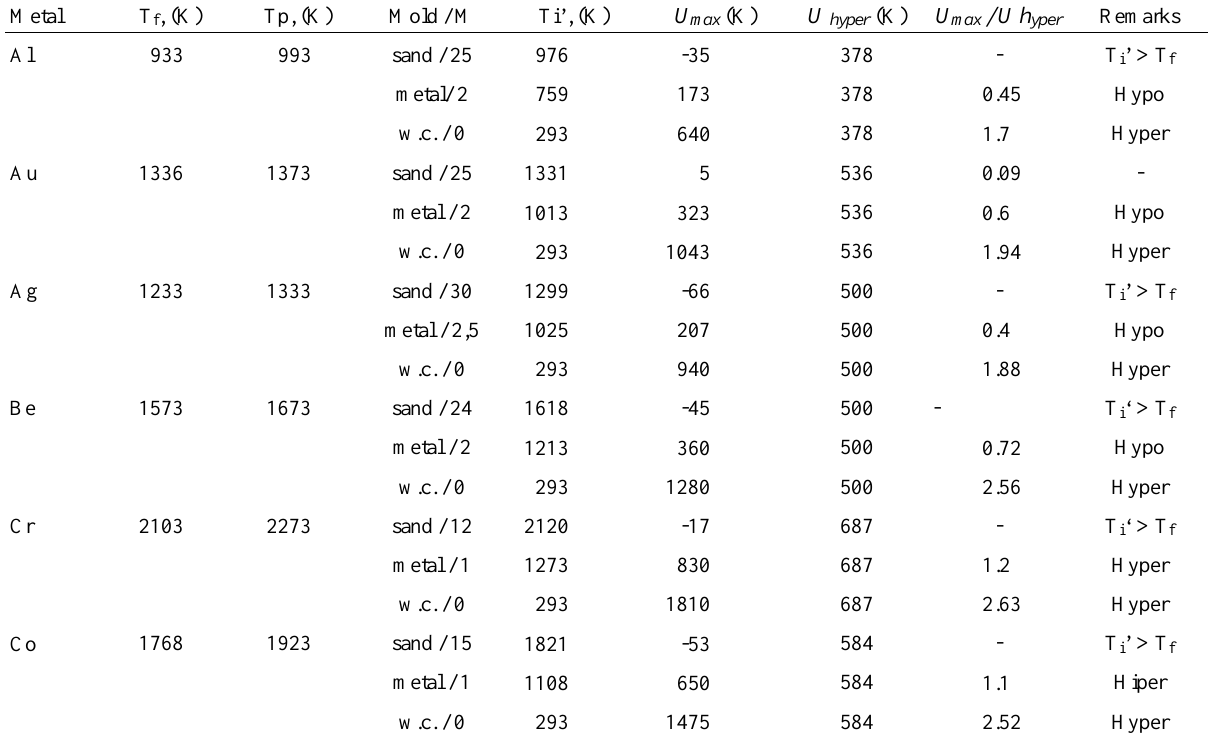
Table 1. Thermal properties and solidification parameters, calculated from Eq. (12) and (20) and (46), for the most common metals (T 0 = 293 K). Metal T f , (K) Tp, (K) Mold / M Ti’,